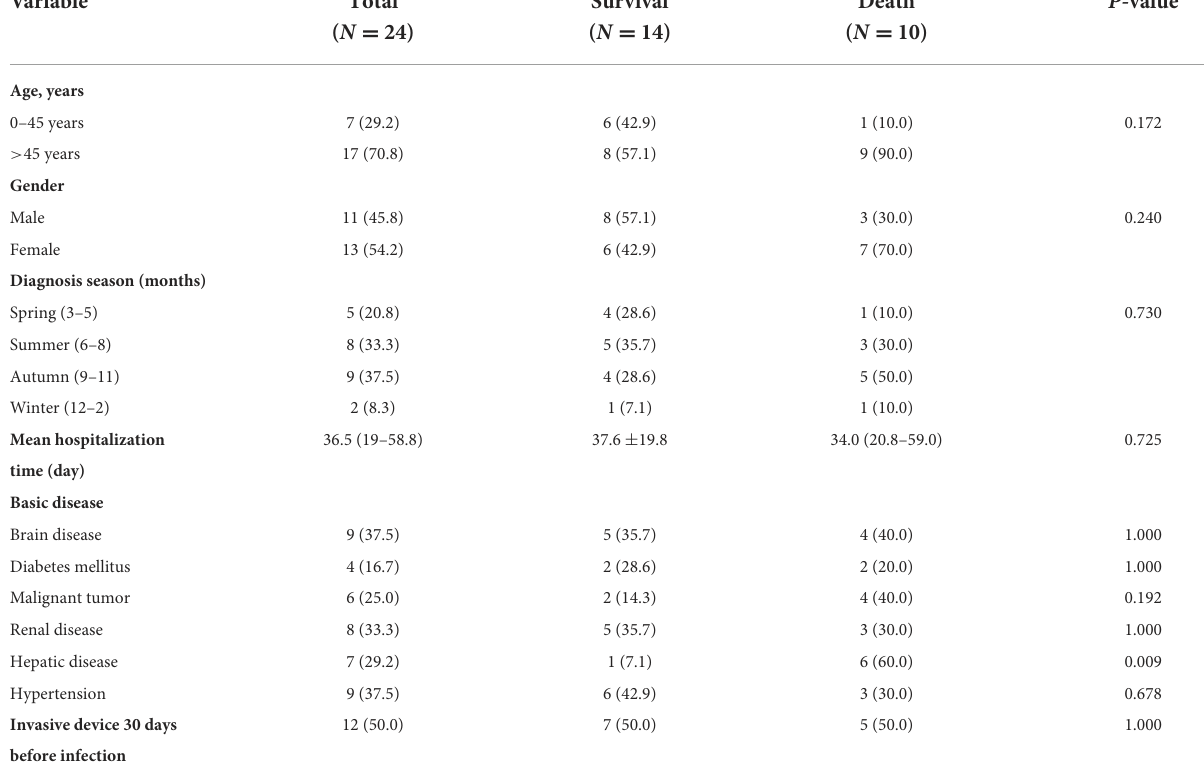
TABLE 1 Demographic and basic disease analysis of patients infected with E. meningoseptica ( N = 24).